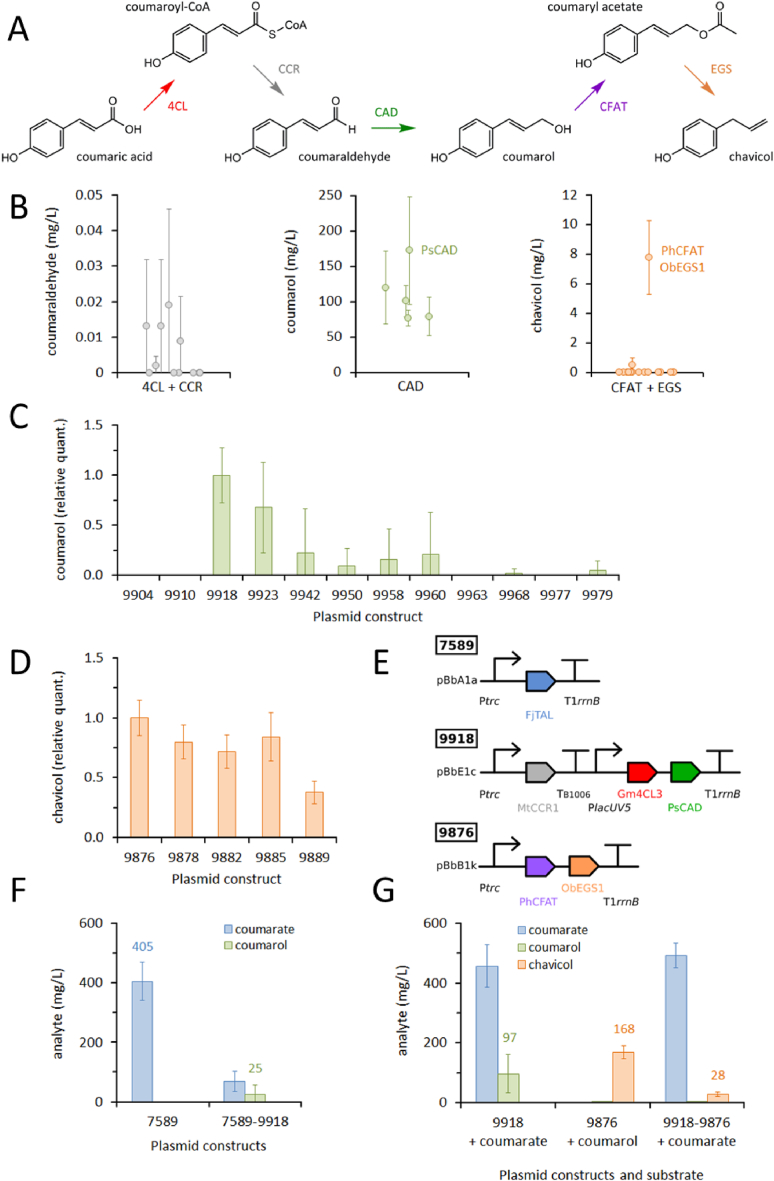
(A) Pathway from coumarate to coumarol and chavicol. Enzyme abbreviations: 4CL (4-coumarate-CoA ligase); CCR (cinnamoyl-CoA reductase); CAD (cinnamyl alcohol dehydrogenase); CFAT (coniferyl alcohol acyltransferase); and EGS (eugenol synthase). (B) Screening enzyme candidates in cell lysates with 3 mM substrate. No enzyme candidates were selected from the paired 4CL + CCR screen fed coumarate. PsCAD (Pseudomonas strain HR199) was selected to convert coumaraldehyde to coumarol. PhCFAT (Petunia hybrida) and OcEGS1 (Ocimum basilicum) were selected for converting coumarol to chavicol. (C) Screening coumarol pathway constructs in DH5α cells fed 3 mM coumarate. After 24 h, SBC009918 was the most productive plasmid. (D) Screening chavicol pathway constructs in DH5α cells fed 3 mM coumarol. After 24 h, SBC009876 was the most productive plasmid. (E) Best performing plasmid constructs. SBC007589 was screened in Fig. 3. MtCCR1 (CCR from Medicago truncatula), Gm4CL3 (4CL from Glycine max). (F) In vivo production of coumarate and coumarol. DH5α (ΔtyrR ΔpheLA) cultures with the indicated plasmids were assayed after 24 h. (G) In vivo production of coumarol and chavicol. DH5α (ΔtyrR ΔpheLA) cultures with the indicated plasmids were fed 3 mM coumarate or coumarol and assayed after 24 h.